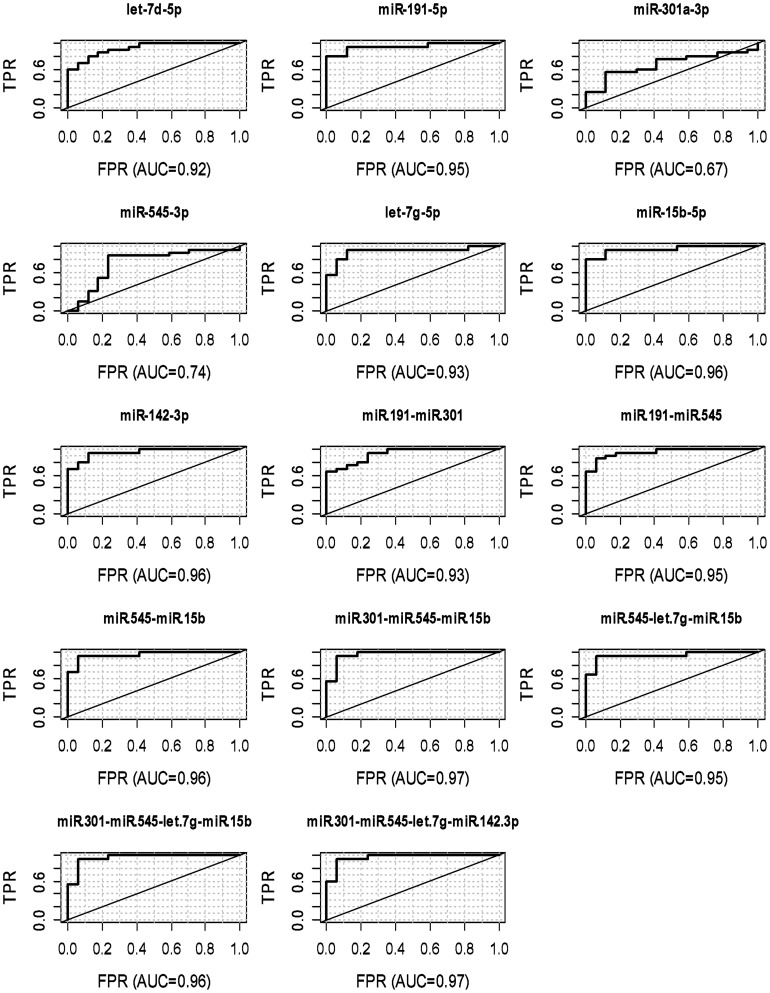
The receiver-operating characteristic (ROC) plots for the miRNA signature.The true positive rate (TPR) is plotted as a function of false positive rate (FPR) for the 7 miRNAs individually (upper panel) and for selected combination of them (lower panel). We used the linear discriminant analysis (LDA) to build a model on the training data (11 AD and 17 controls) to predict the AD status of 37 patients (20 AD and 17 controls). These miRNA combinations are all characterized with high area under the curve (AUC) values (>0.93).